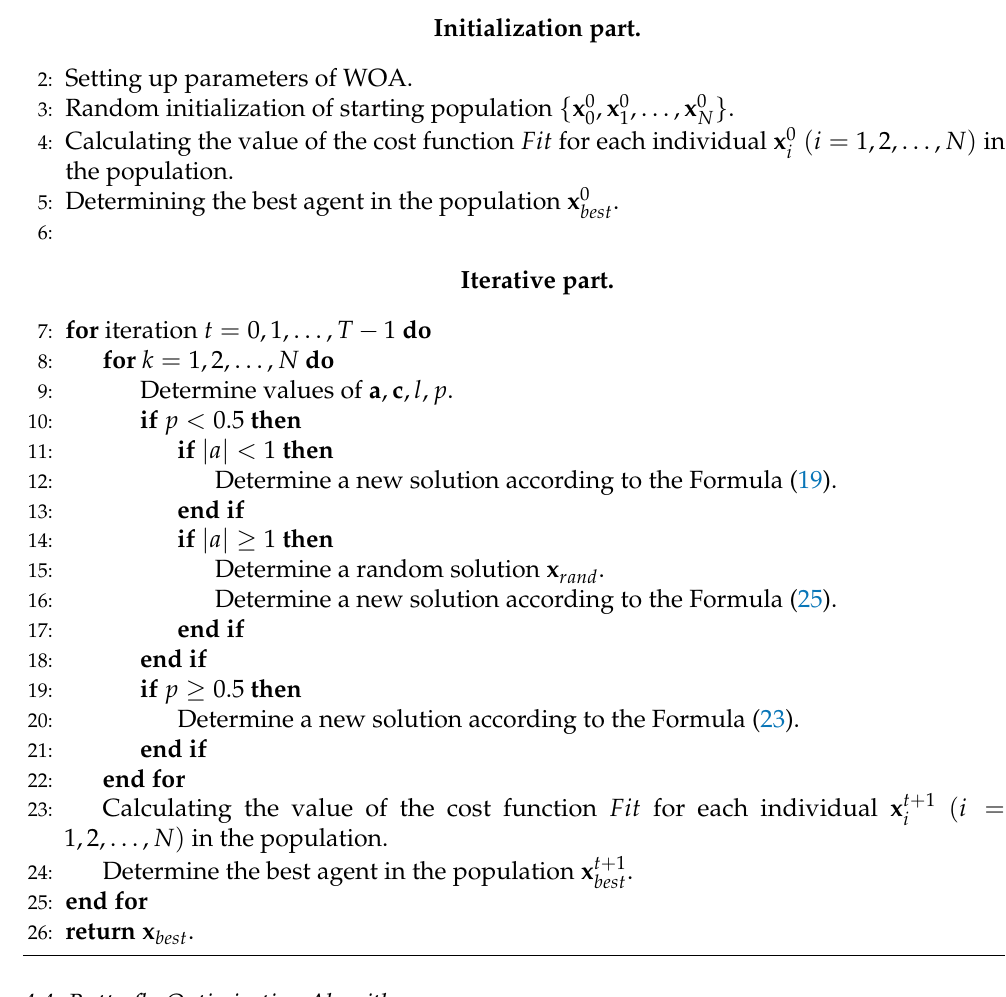
Algorithm 3 Whale optimization algorithm (WOA)